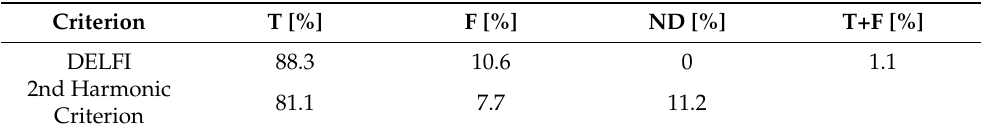
Table 3. Validity assessment: number of events for each label and criterion expressed as a percentage of the total number of events.